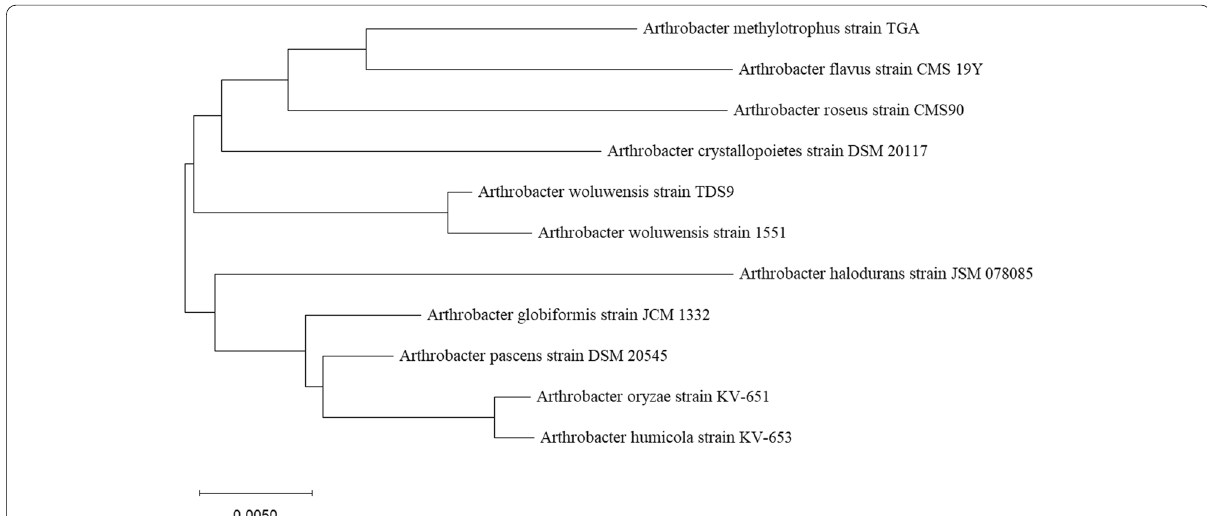
Fig. 1 Phylogenetic tree derived by neighbor joining method using 16s rRNA gene sequencing of A. woluwensis TDS9 and other species of Arthrobacter , showing evolutionary relationship between TDS9 and other related species. Blast information from the NCBI and MEGA software of version 10.0 was used to build the phylogenetic